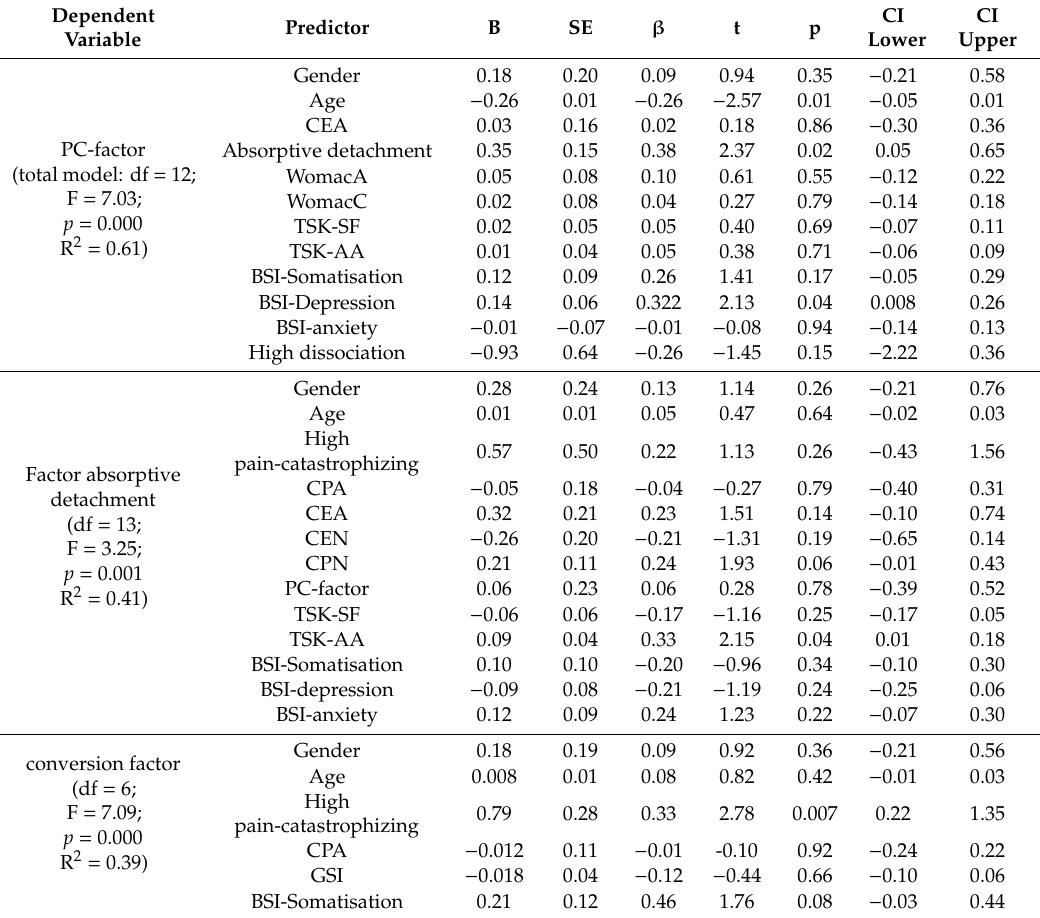
Table 5. Linear regression analyses, dependent variables: factors PC-factor, absorptive detachment, and conversion. WOMAC A / C: knee-pain / -function; CEA: childhood emotional abuse; CPA: childhood physical abuse, CEN: childhood emotional neglect, CPN: childhood physical neglect, TSK-SF: subscale somatic focus (Tampa scale of kinesiophobia), TSK-AA: subscale activity avoidance (Tampa scale of kinesiophobia), BSI: brief symptom inventory, GSI: general severity index (summary score of the BSI). Dependent